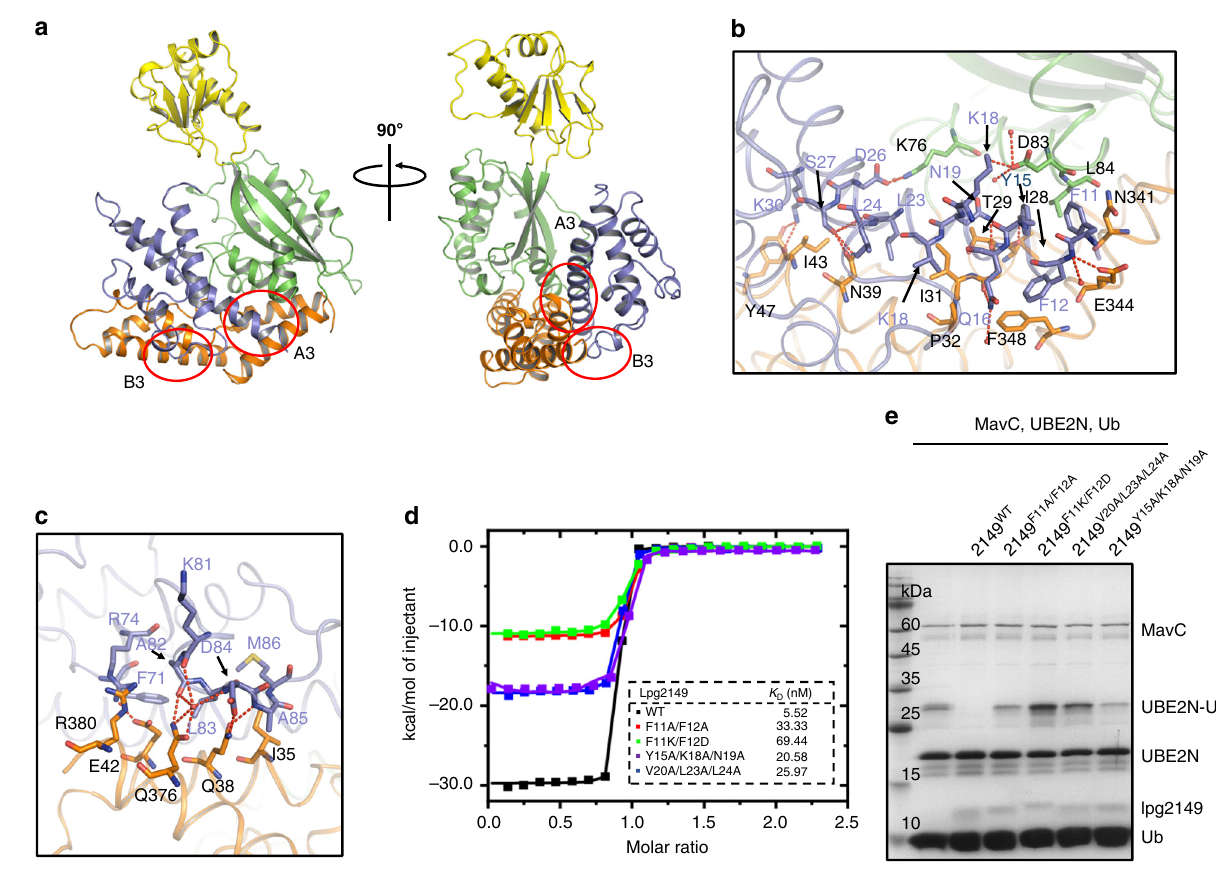
Fig. 4 The inhibition mechanism of MavC by Lpg2149. a Overall structure of MavC/Lpg2149. MavC is colored as in Fig. 1a and Lpg2149 is colored in blue. b, c Detailed interface of MavC – Lpg2149 interaction as marked in a , including A3 b and B3 c . d Isothermal titration calorimetry (ITC) assays to test binding of the Lpg2149 mutants to MavC. Representative binding curves and binding. af fi nities are shown. e Mutations that disrupt MavC – Lpg2149 interactions affect the inhibition capacity of Lpg2149. Lpg2149 and the mutants were incubated with MavC, UBE2N, and Ub for 2 h at 37 °C. Then the samples were treated as in Fig. 1i. Source data are provided as a Source Data fi le. The experiment was repeated independently three times with similar